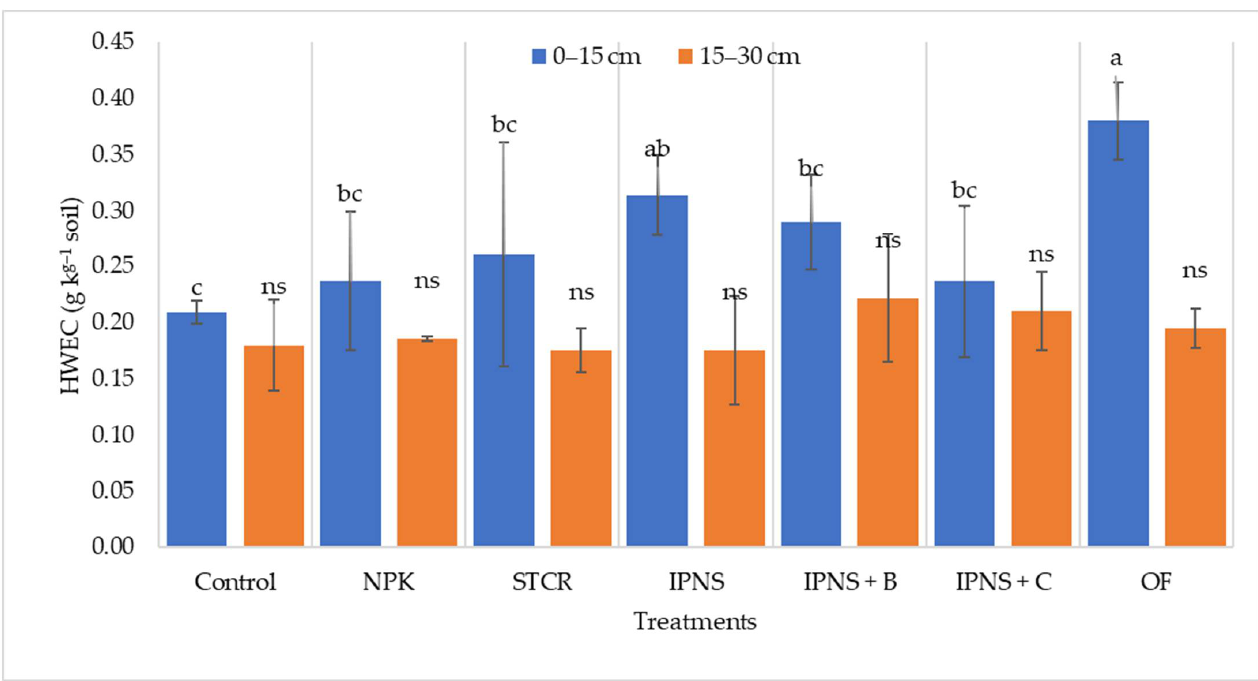
Figure 5. Effect of nutrient management on HWEC. Means ± standard deviation of different treat- ments followed by the different lower-case letter (a–c) are significantly different at p < 0.05 level of significance according to DMRT, NS—non significant.